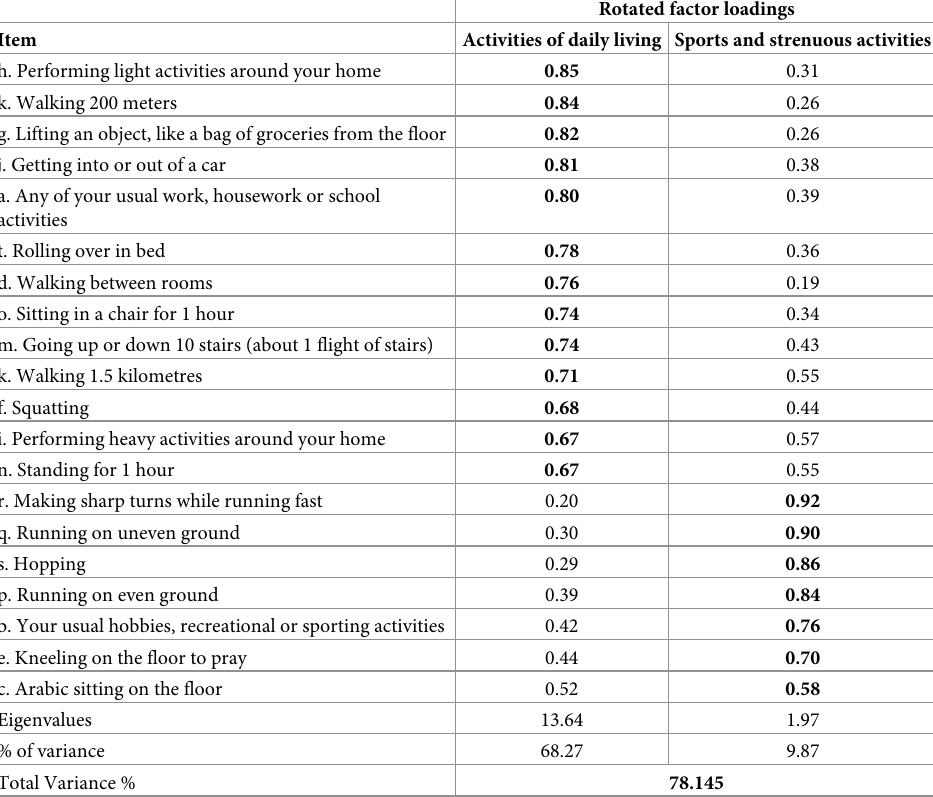
Table 5. Exploratory factor analysis with varimax rotation suggesting a 2-factor solution.